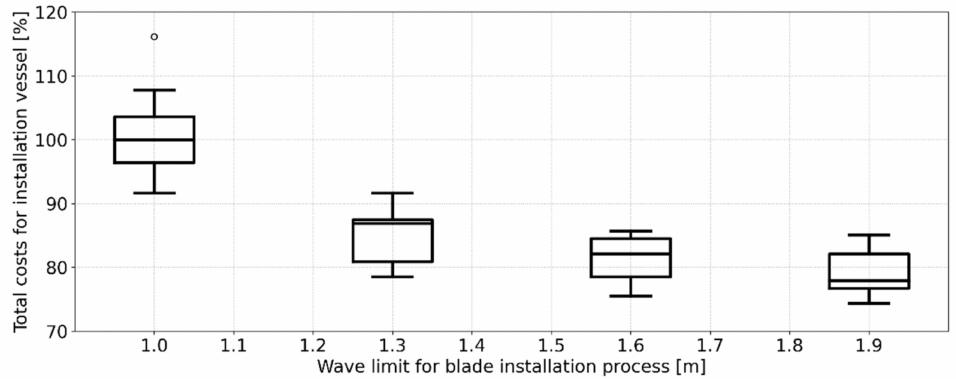
Figure 7. Costs for the installation vessel depending on wave height.